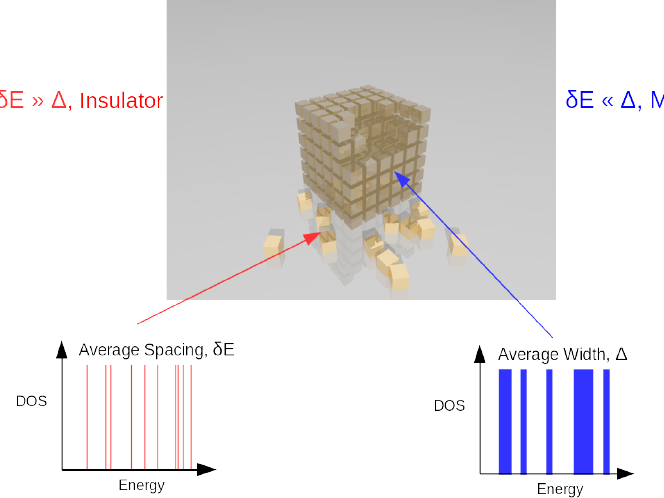
Figure 4. To help understand localization, we divide the system into blocks. The average spacing of the energy levels of a block is δ E and the Fermi golden rule width of the levels is ∆ . If ∆ δ E , an have a metal and if ∆ (cid:28)